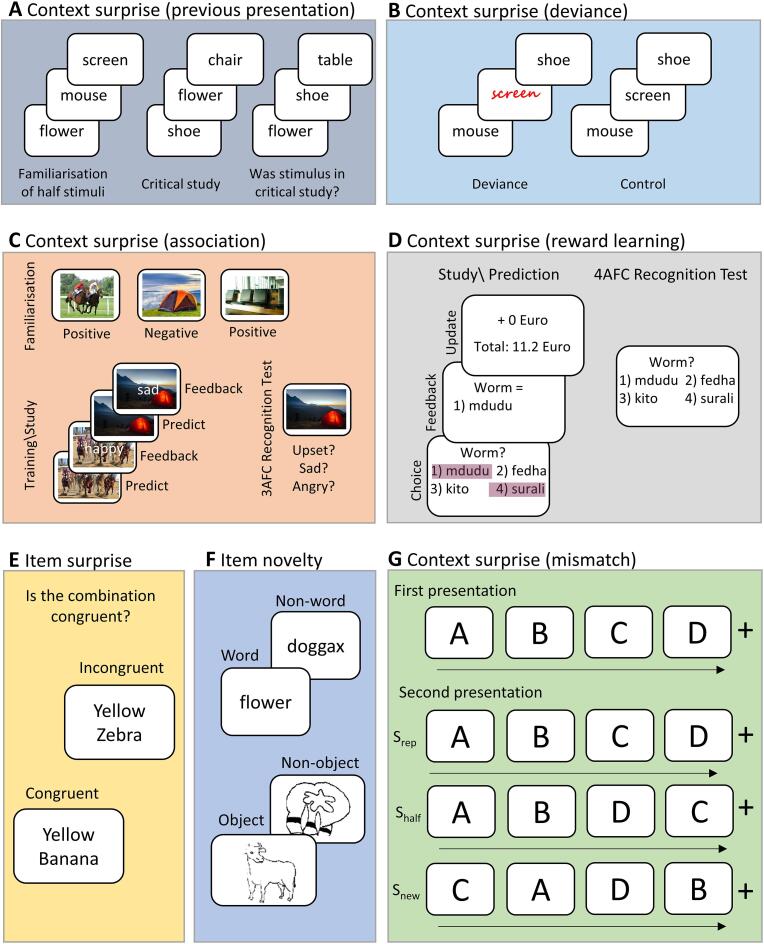
Illustration of key paradigms. Panel A: Design by Tulving and Kroll (1995): pre-familiarised and novel items are presented intermixed at critical study for which recognition memory was later tested. Panel B: Design of von Restorff/distinctiveness paradigm: items of the same type/class are presented in lists together with a conceptually or perceptually deviant item (e.g. different font type/colour), memory for which can compared to an item same position in a control list without deviants. Panel C: Rule based design by Greve et al. (2017): At study new scenes were paired with new words, which had the same valence as expected from a previous familiarisation phase (low PE) or the opposite valence (high PE). A forced-choice memory test matched target and foils to be of same valence and equally familiar. Panel D: Reward PE design by De Loof et al. (2018): one, two or four Swahili words are presented as options from which the rewarded word is selected, which manipulated the size of RPE. Panel E: Design by Reggev et al. (2018): Judging whether a noun-adjective is congruent and subsequently testing memory for the nouns. Panel F: Item novelty assessed by presenting objects vs. non-objects or words vs. non-words in Kroll and Potter (1984). Panel G: Mismatch design from Kumaran and Maguire (2006): sequences of objects were represented twice, wherein the second presentation, the order of objects was either unchanged (Srep), changed after the first half (Shalf) or completely new (Snew).